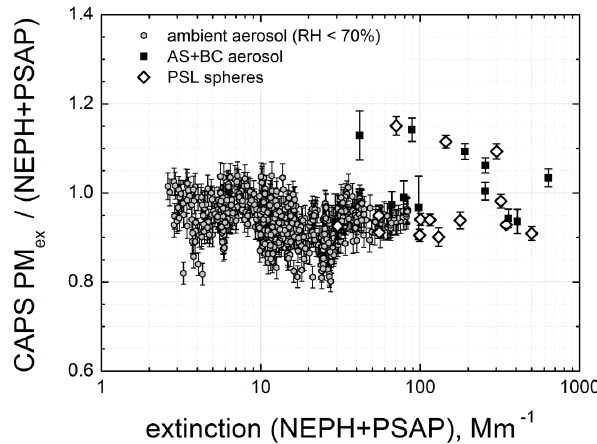
Fig. 11. Intercomparison of extinction measured by CAPS PM ex Figure 11. Intercomparison of extinction measured by CAPS PM ex and extinction obtained and extinction obtained from the combined NEPH + PSAP analysis from the combined NEPH+PSAP analysis for ambient aerosols. The dashed lines represent for ambient aerosols. The dashed lines represent the 1 : 1 relation the 1:1 relation and errors bars indicate the  3% uncertainty range of CAPS PM ex data and errors bars indicate the ± 3% uncertainty range of CAPS PM ex data.